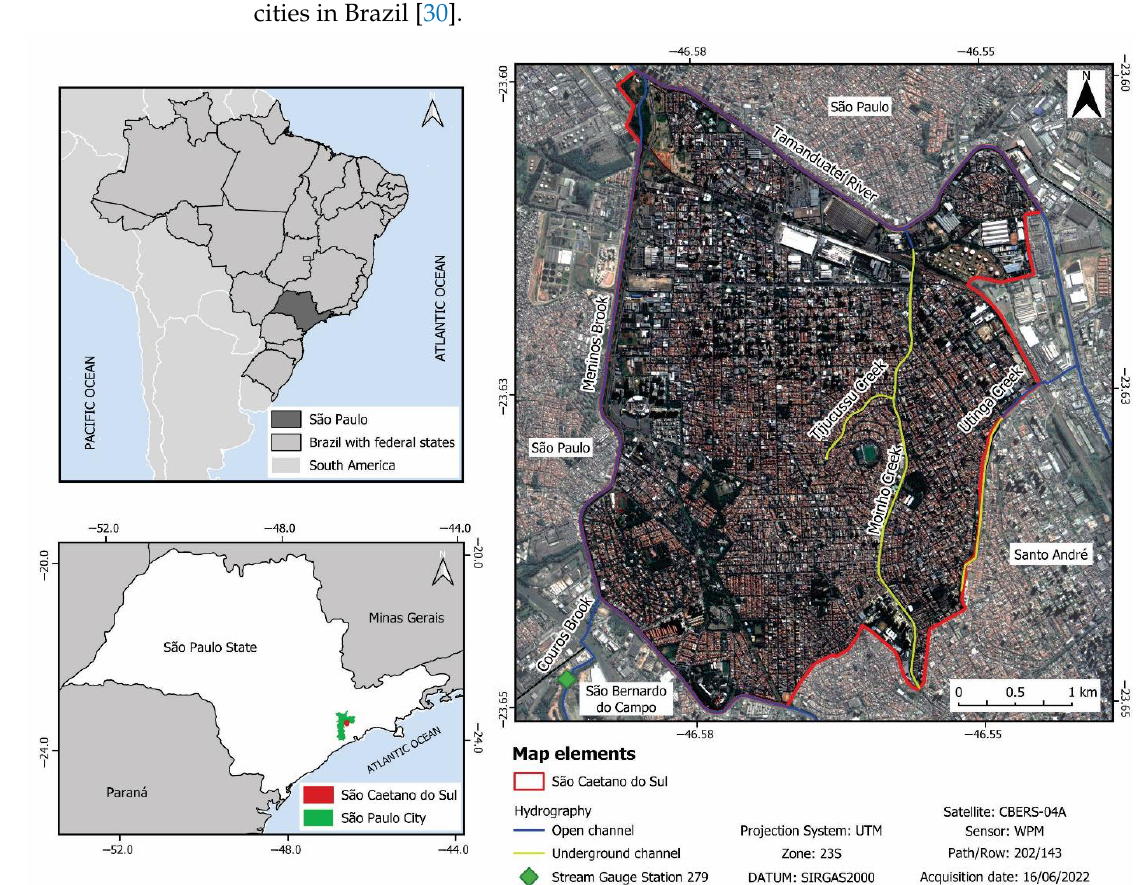
Figure 1 . Study area location . Figure 1. Study area